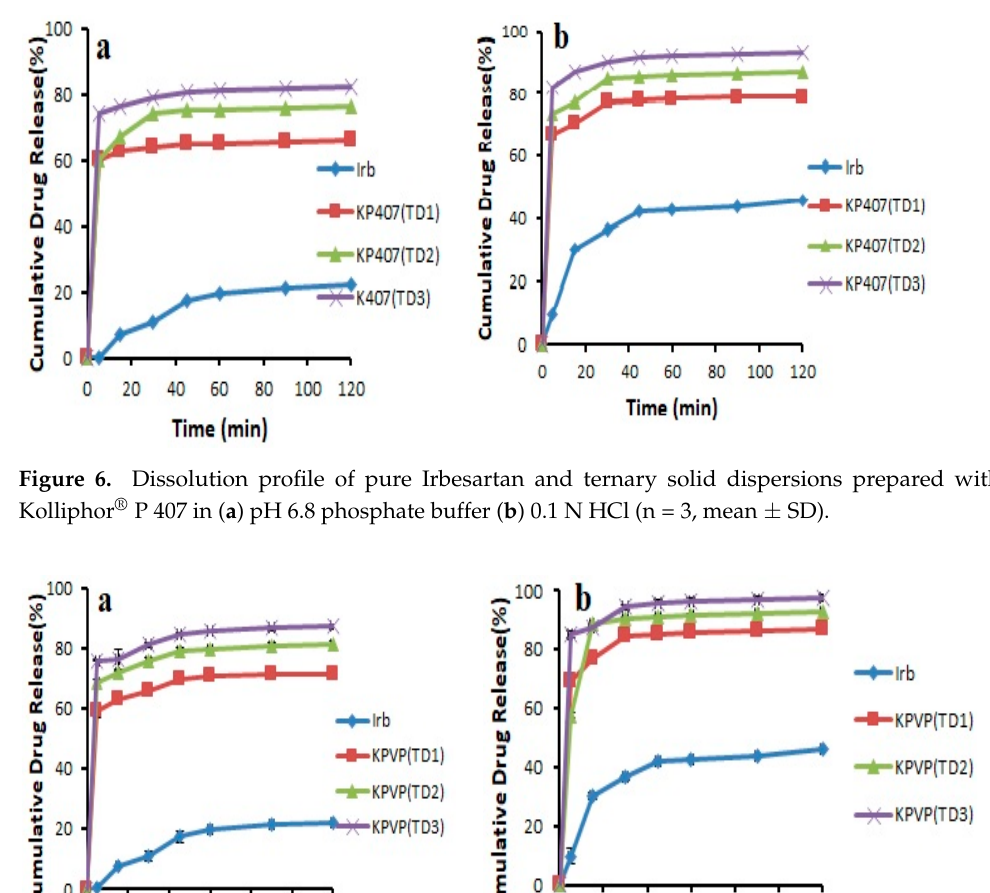
Figure 5. Dissolution profile of pure Irbesartan and binary solid dispersions prepared with Kol- lidon ® VA 64 in ( a ) pH 6.8 phosphate buffer ( b ) 0.1 N HCl (n = 3, mean ± SD).